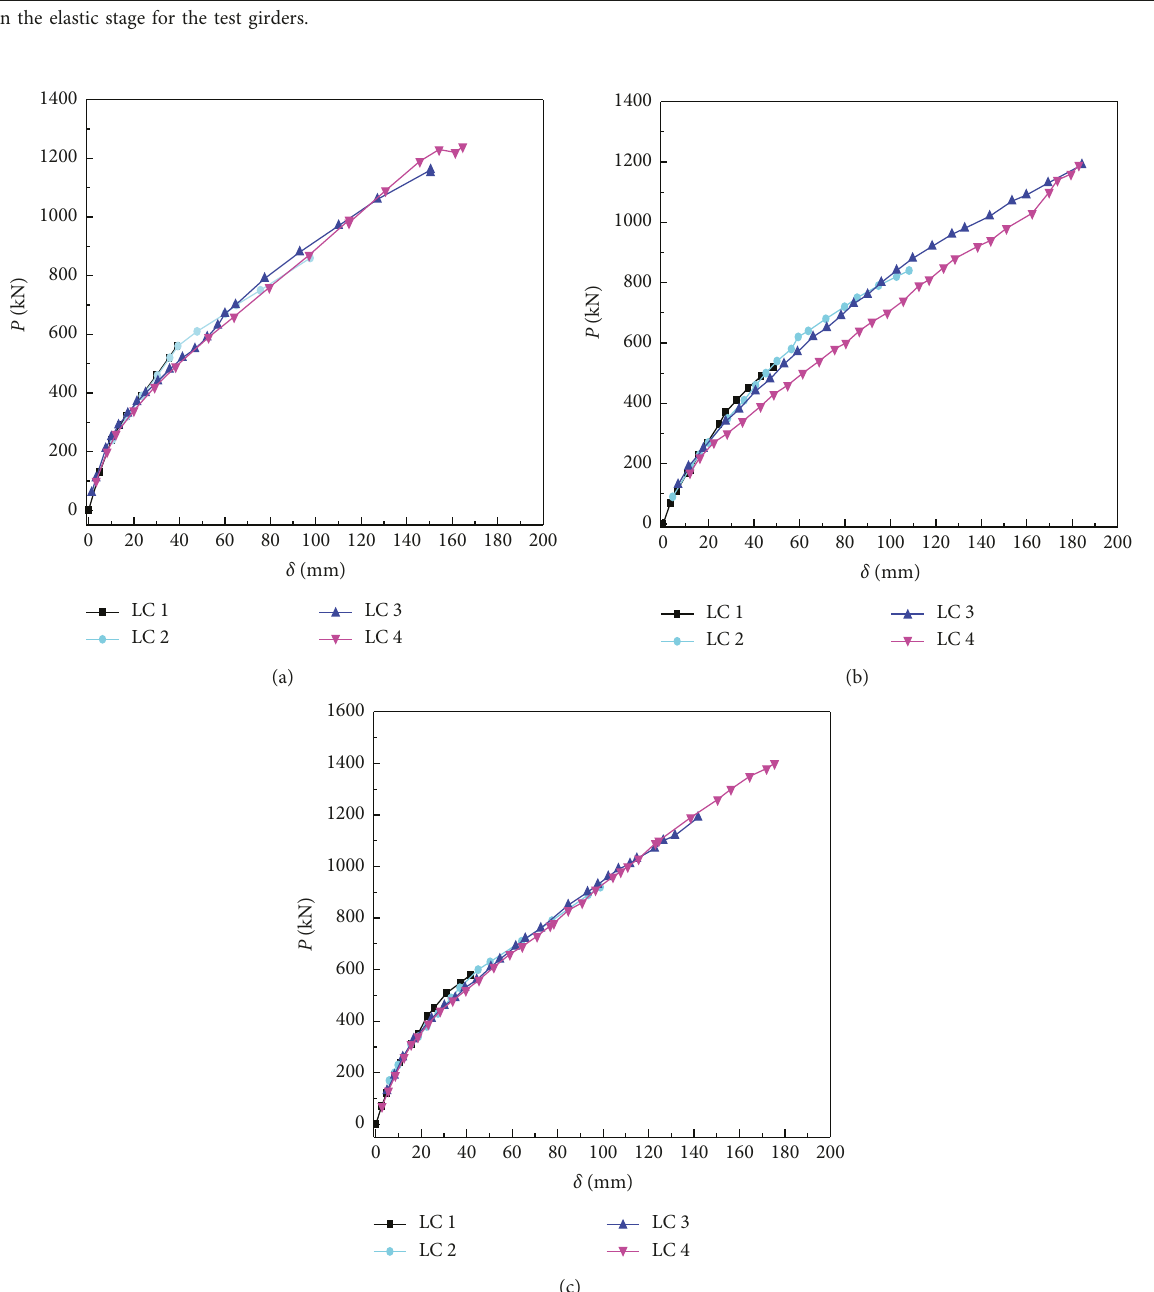
Figure 9: Relationship between load and deflection at the midspan locations. (a) Girder Z1. (b) Girder Z2. (c) Girder B1.